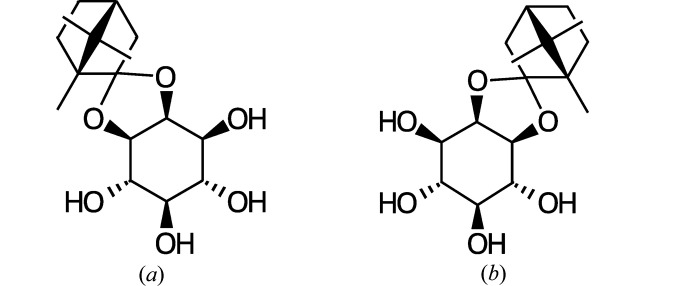
Structural formula of (a) 1 and (b) its enantiomer described by Gainsford et al. (2007) ▸.